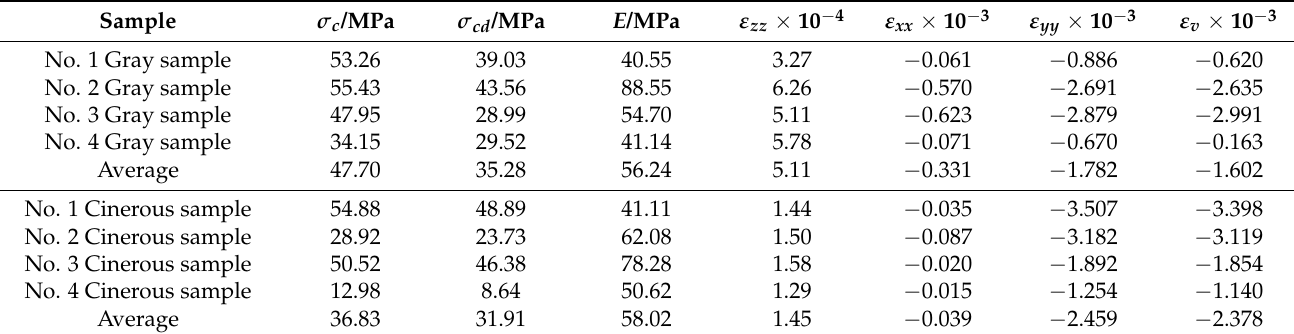
Table 2. Mechanical Parameters for Parallel